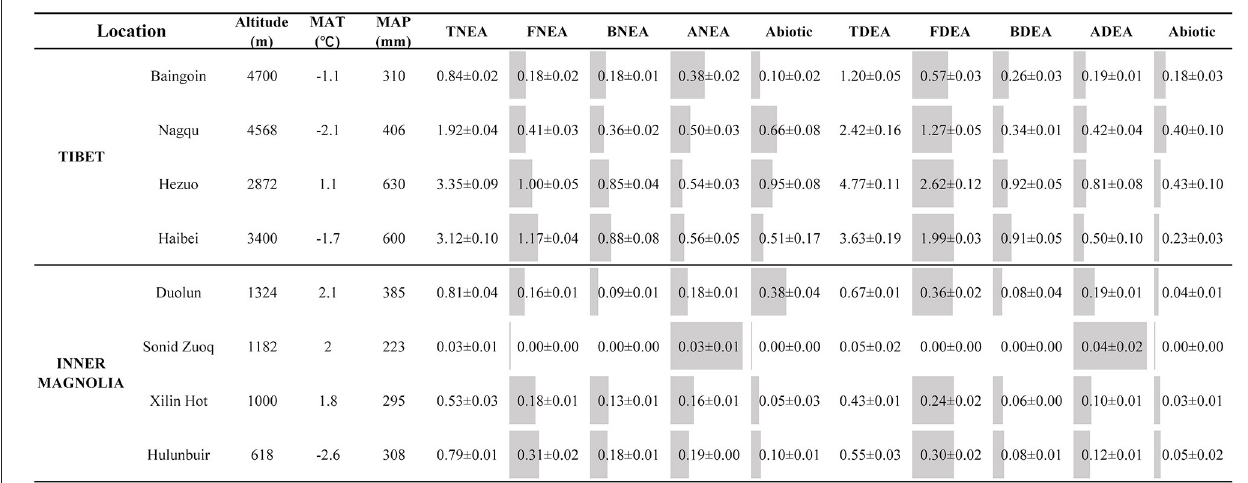
FIGURE 1 | The activities of nitrification and denitrification enzymes from fungi (FNEA and FDEA), bacteria (BNEA and BDEA), and archaea (ANEA and ADEA) and total nitrification and denitrification enzymes activities (TNEA and TDEA) at different sampling sites in grassland soils. The values represent means ± 1 SEM ( n = 4). The length of the gray bar means the contribution percentage of fungi, bacteria, archaea, and abiotic on the total nitrification or denitrification enzymes activities (0% equal to 0cm, 100% equal to cell